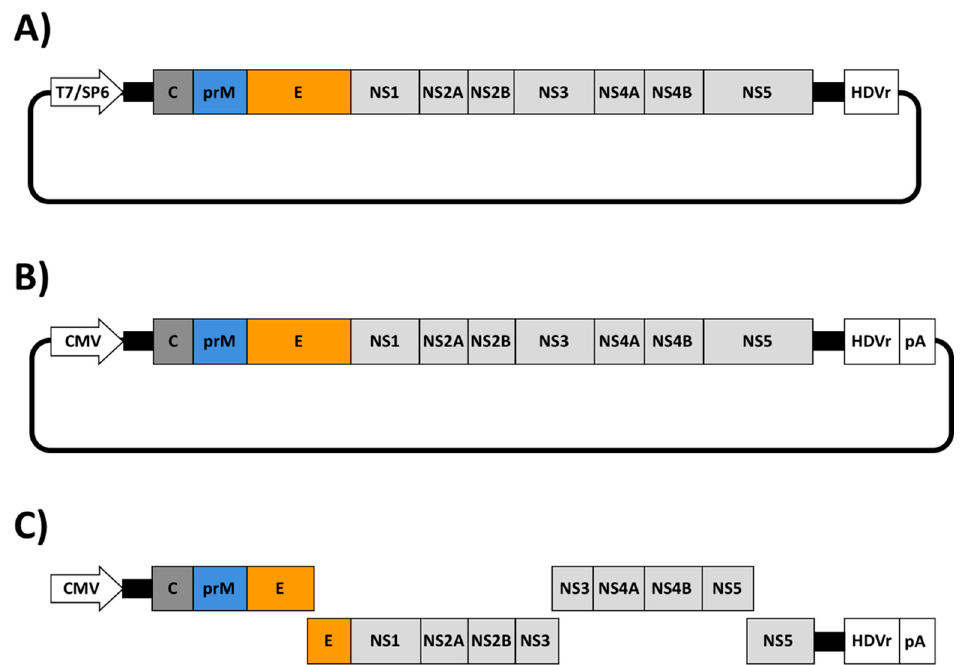
Figure 2. Schematic representation of ZIKV reverse genetic approaches. ( A ) Infectious RNA transcripts from full-length cDNA clones: A full-length genomic cDNA clone containing the ZIKV genome flanked by a prokaryotic promoter (e.g., T7 or SP6) and the hepatitis delta virus ribozyme (HDVr) is usually assembled in a low-copy plasmid. In this approach, in vitro transcription is required to produce viral RNA that is transfected into susceptible cells to initiate viral replication and transcription in the cytoplasm of transfected cells. ( B ) Full-length infectious genomic cDNA clones: A full-length infectious genomic cDNA clone containing the viral genome flanked by a polymerase II-driven promoter from cytomegalovirus (CMV) and the HDVr followed by a polymerase II terminator and polyadenylation signal (pA) is assembled in a low-copy plasmid. In this case, the full-length cDNA clone is transcribed in the nucleus of transfected cells by the cellular RNA polymerase II. Primary transcripts are translocated to the cytoplasm where further amplifications steps are conducted by the viral polymerase. ( C ) Infectious Subgenomic Amplicons (ISA): The ISA approach can be used for the production of infectious viruses from genomic DNA material, including pre-existing infectious cDNA clones, viral RNA or de novo synthesized DNA genomic sequences. The entire viral genome is amplified by overlapping PCR reactions with each PCR product containing 30–40 base pairs overlapping regions [45]. The first and last PCR products are flanked by the CMV promoter and the HDVr followed by a polymerase II terminator and pA signal, respectively. Co-transfected cDNAs result in self-assembly in the cytoplasm of susceptible cells and virus